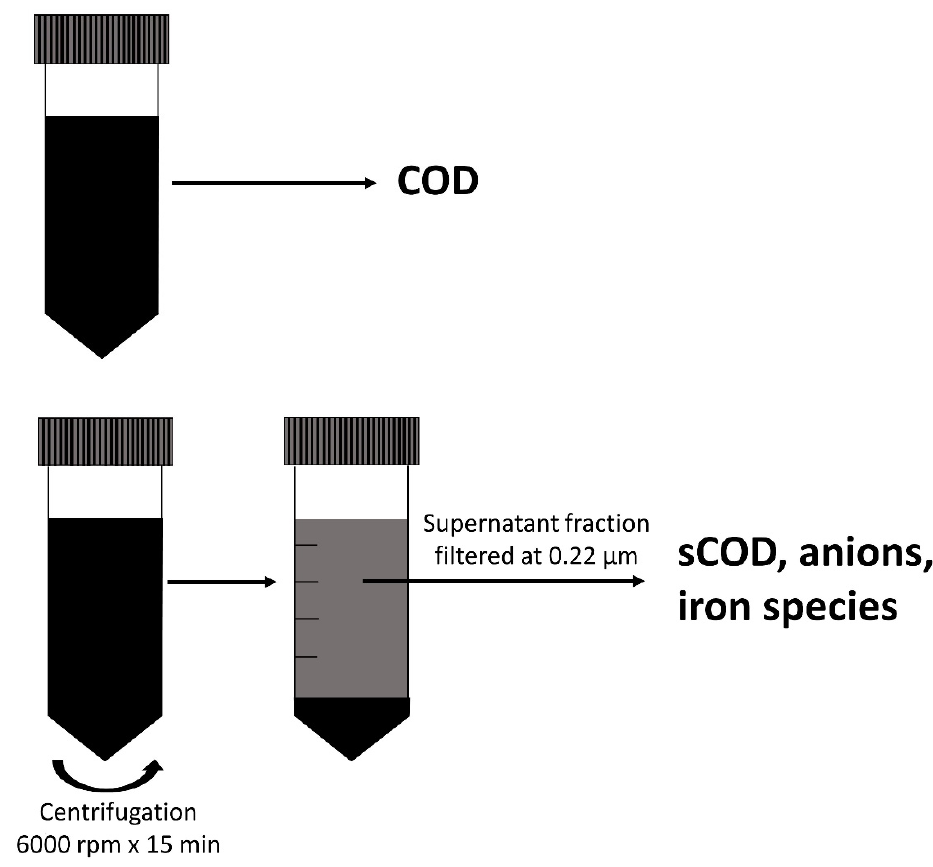
Figure 2. Procedure for obtaining samples for sludge characterization analysis.